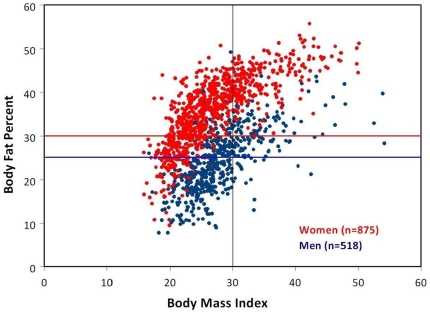
BMI versus Percent Body Fat in Scatter Plot.Women (red) who fall above red line are obese according to American Society of Bariatric Physicians criteria (DXA percent body fat: ≥30%). Men (blue) who fall above blue horizontal line are obese according to American Society of Bariatric Physicians criteria (DXA percent body fat: ≥25%). The upper left quadrant bordered by red horizontal line (body fat percent = 30%) and black vertical line (BMI = 30) demonstrates large number of women misclassified as “non-obese” by BMI yet “obese” by percent body fat.